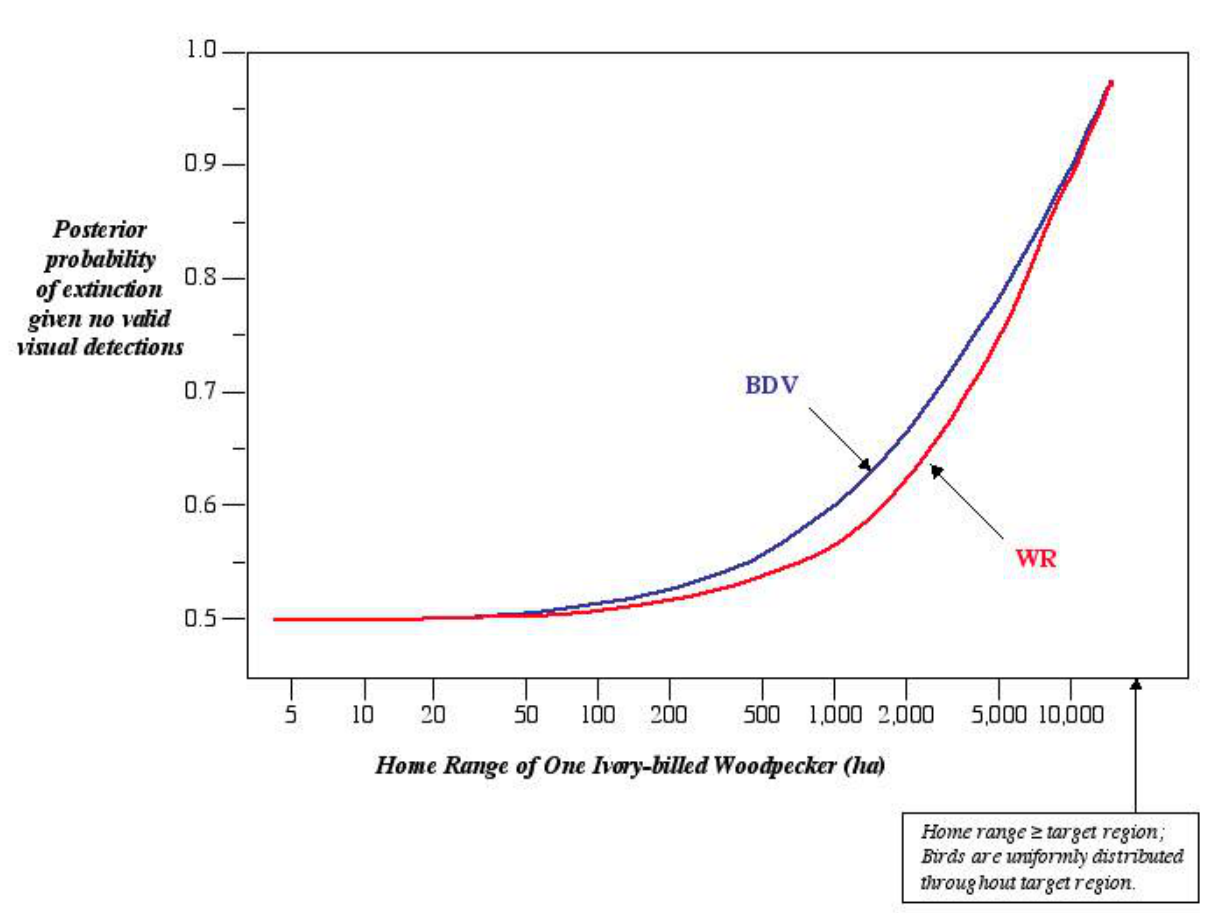
Fig. 4. The relationship between home-range size and posterior probability of extinction given no valid visual detections and the search efforts at White River (WR) and Bayou de View (BDV). We assume a geometric prior distribution with prior probability of extinction being 0.5. The arrow indicates a home range as large as the surveyed area; this gives the same results as having birds uniformly distributed throughout the